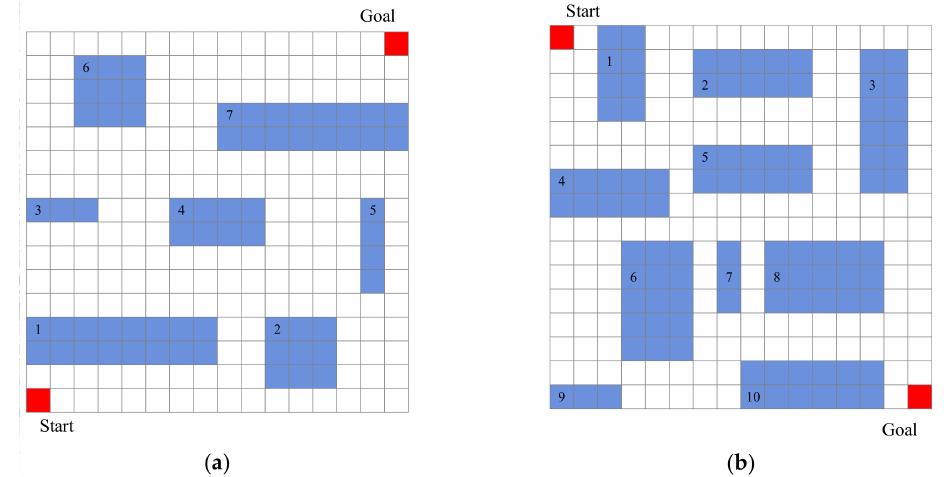
Figure 20. Representation of environments. ( a ) Environment 1; ( b ) Environment 2.